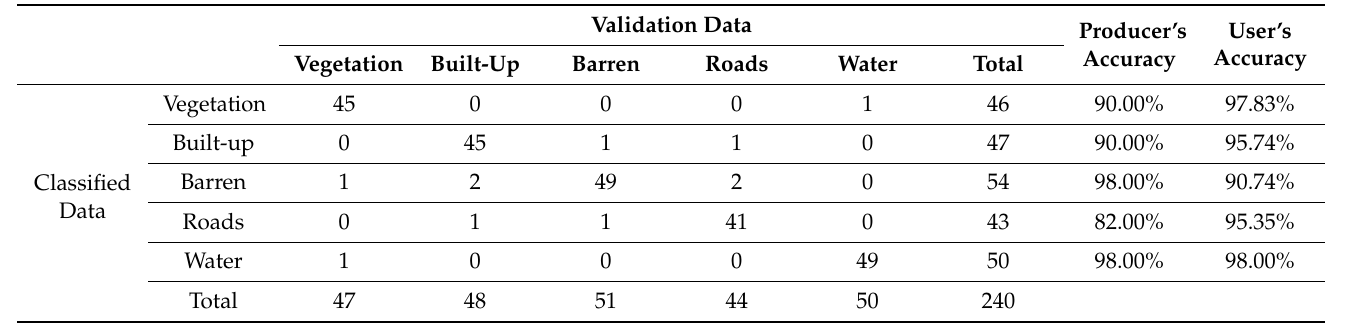
Table 4. Error matrix, producer’s accuracy, and user’s accuracy for LULC classification of LANDSAT 8OLI/TIRS.